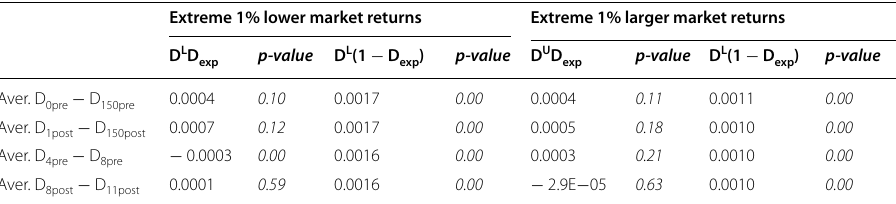
Table 7 Robustness tests using the CH(1995) model